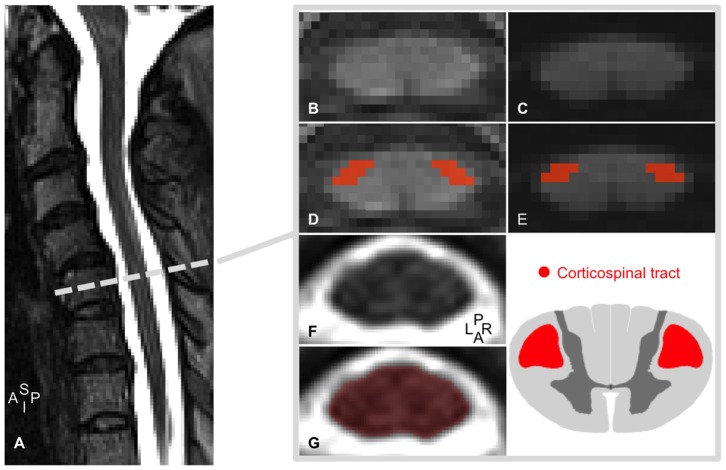
Regions of interest definition.(A) T2-weighted MRI mid-sagittal slice for an ALS patient. (B,C) T1-weighted data for MTR (B) and mean diffusion-weighted data for DTI (C). (D,E) Defined anatomical ROIs. ROIs were selected in the dorso-lateral (red) aspect of the spinal cord to include most of the CST. (F,G) T2-wheighted data before (F) and after (G) cord outlining. A, anterior, I, inferior; L, left; R, right; P, posterior; S, Superior.